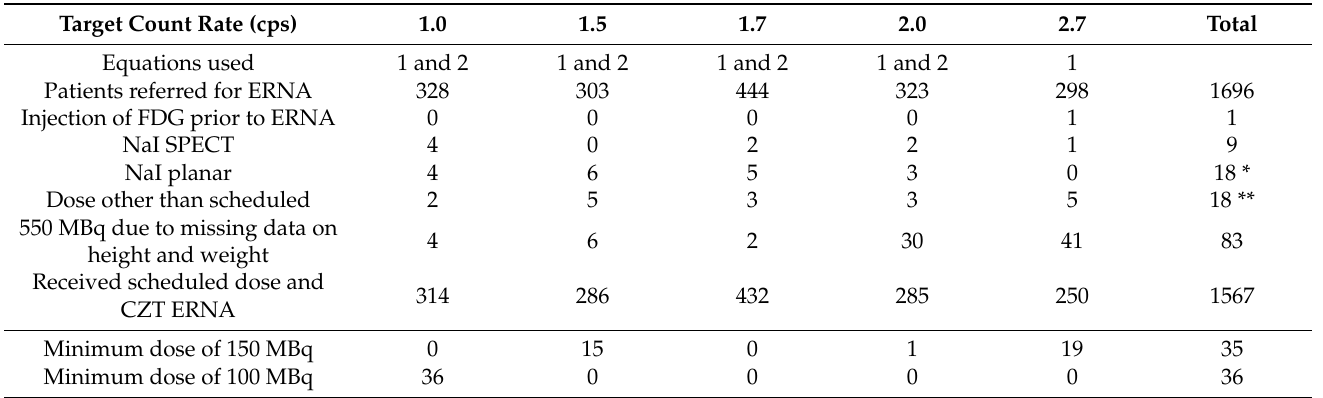
Table 1. Detailed information on patient flow with regard to target count rate and cameras used for ERNA. Target Count Rate